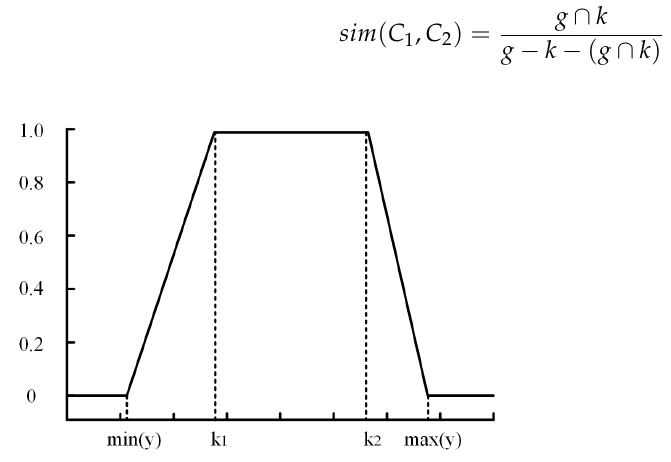
Figure 5. Fuzzy interval affiliation